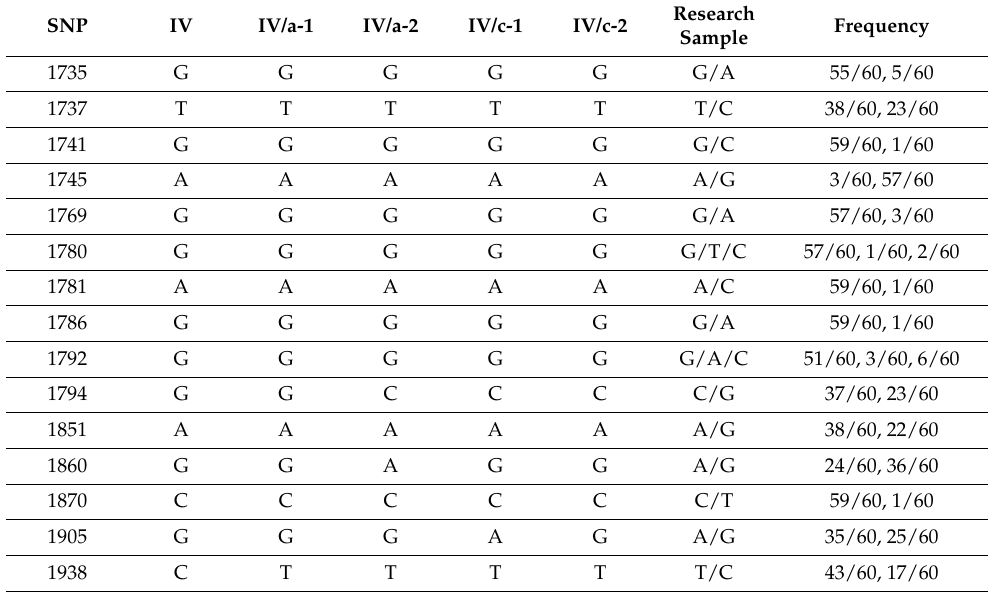
Table 9. SNP positions among BKV-IV subgroups in the VP1 gene region.